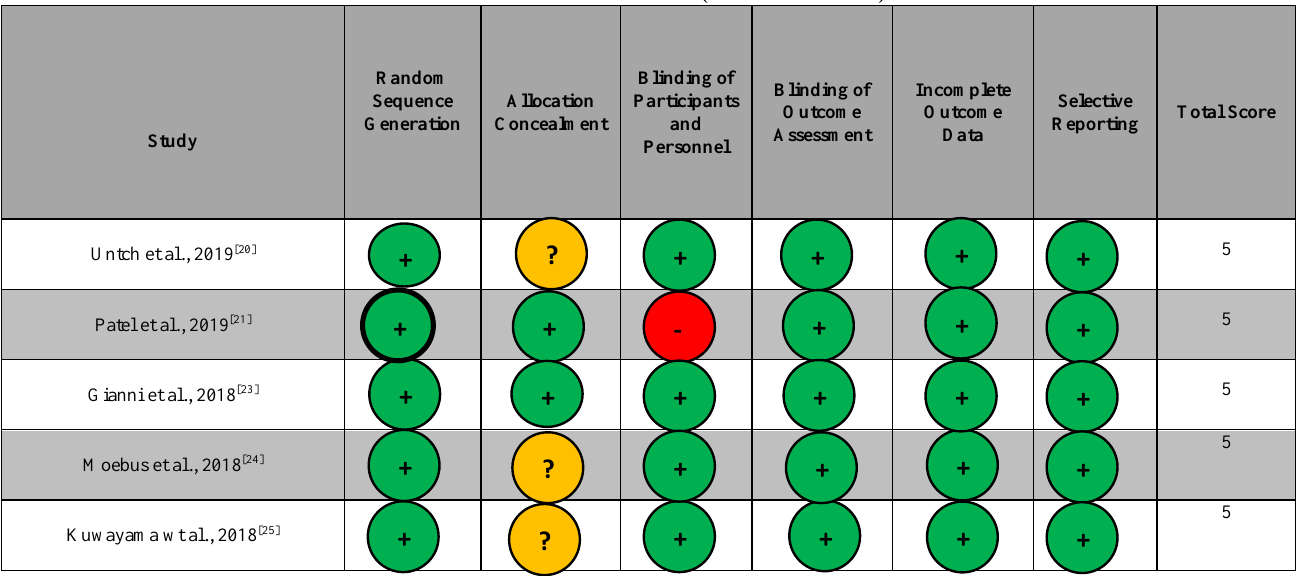
Table 4. Risk of bias assessment (Collaboration’s tool).